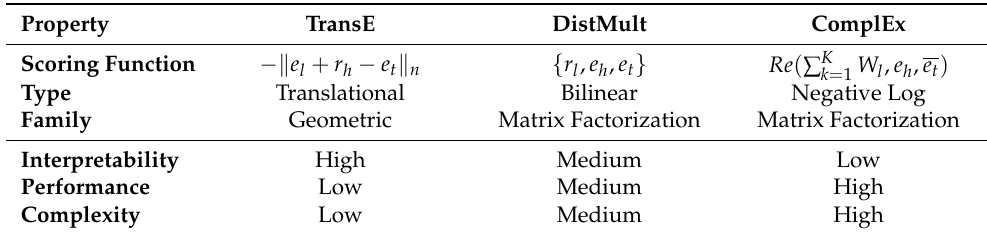
Table 1. Selected models breakdown by type for the question-answering evaluation. h , l , t represent the head, relation, and tail of the triple, respectively, while the W means the parameter matrix and K the rank of the